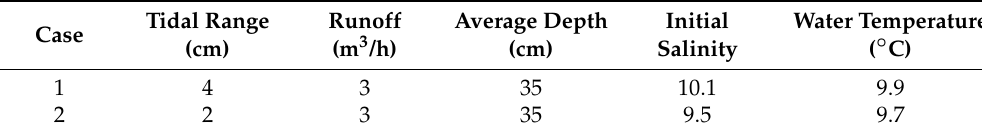
Table 1. The conditions of Case 1 and Case